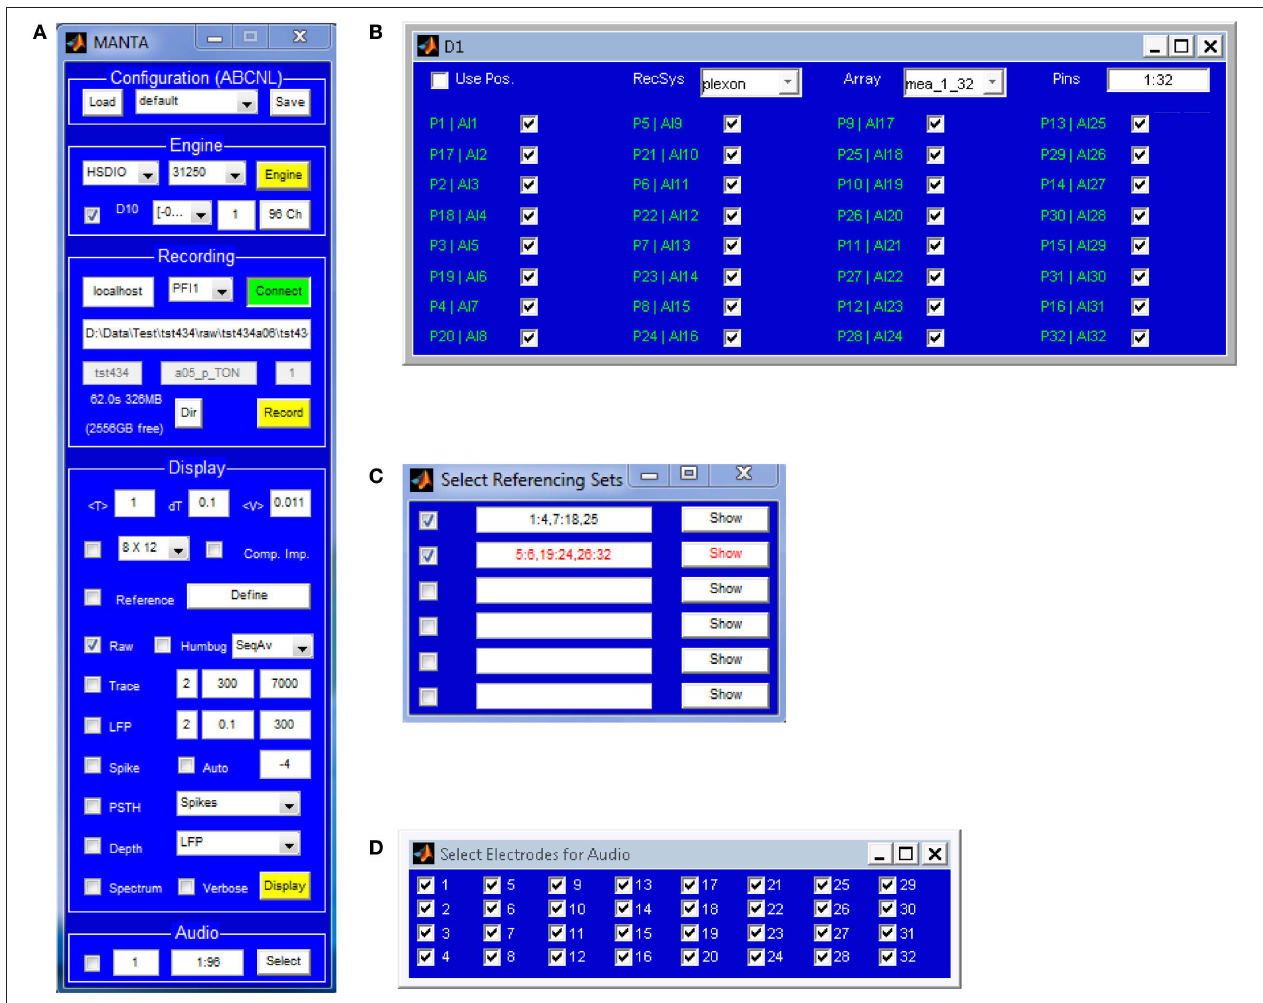
recording when controlled remotely. The Display panel holds the options for the graphical representation of the data, which can be modified/toggled during an active acquisition session, without interrupting acquisition. Options include to filter the signal within different bands (typically LFP and spike band), trigger spikes, common mode notch filtering, Fourier spectrum display, and common average referencing for several sets of channels (C) . The Audio panel allows to select a subset of channels and output to computer speakers. An audio selection panel can be opened to individually select the channels to play ( D